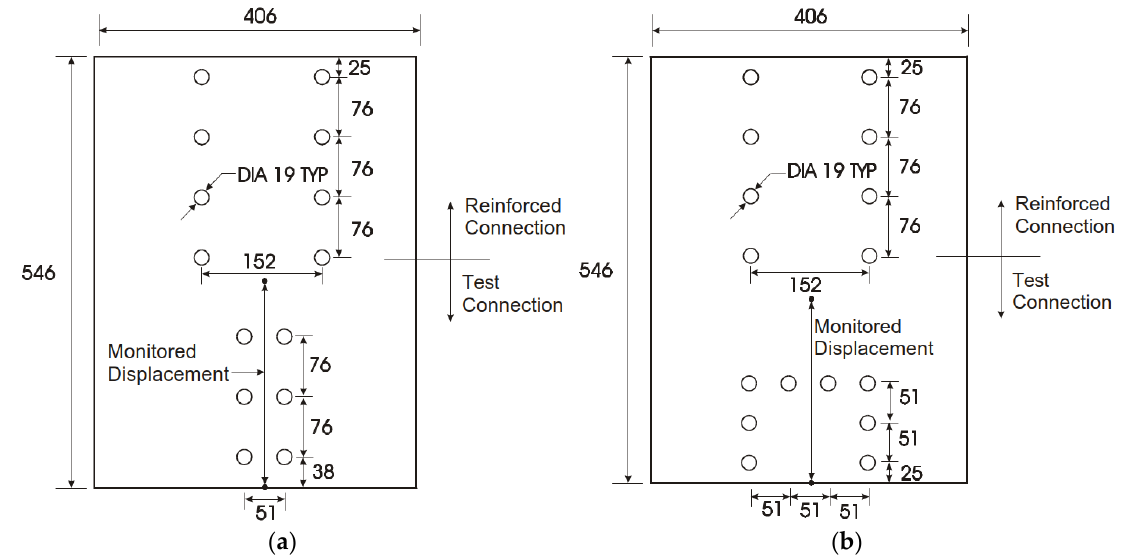
Figure 5. Tested gusset plate connections: ( a ) specimen T1 and ( b ) specimen T2 [7], dimensions in